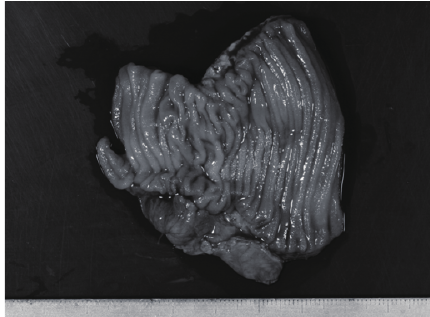
Figure 4: The excised ileum showed no particular abnormal findings despite the caliber